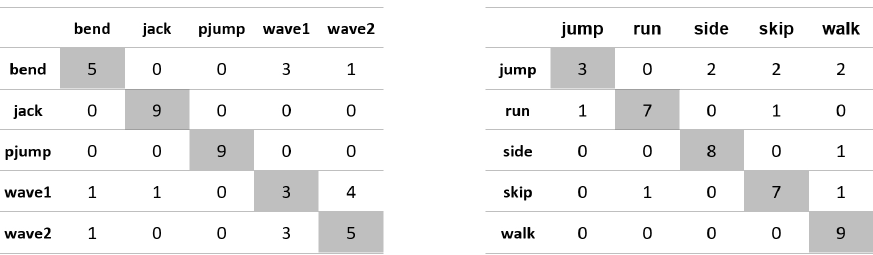
Figure A35. Confusion matrices for the experiment using the ‘upper-occlusion’ database, shorterMBR and C1 correlation.